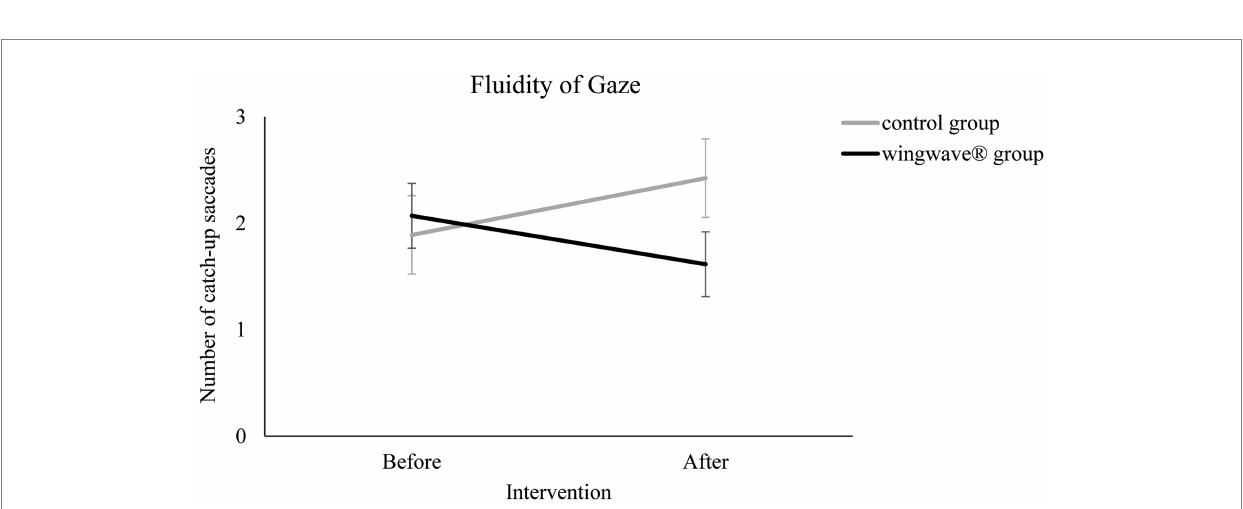
FIGURE 3 Fluidity of gaze measured as the number of catch-up saccades made during the object-tracking task as a function of treatment group (wingwave ® , control) and moment of testing relative to intervention (before, after). Error bars indicate